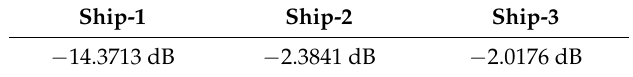
Figure 5. The ED distribution for S-RN signals. The ED distribution for S-RN signals (20 samples for each ship) is shown in Figure 5. As can be seen from Figure 5, the ED of the same ship remained at the same level. We could easily distinguish Ship-1 by using ED, however, it was difficult to distinguish between Ship-2 and Ship-3, due to their similar EDs.